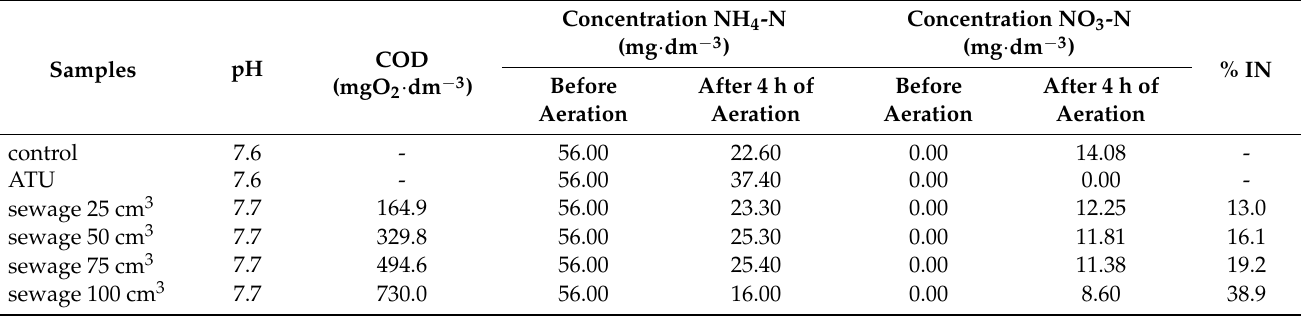
Table 7. Influence of COD of industrial wastewater from polyvinyl acetate production on the nitrification inhibition in activated sludge under laboratory